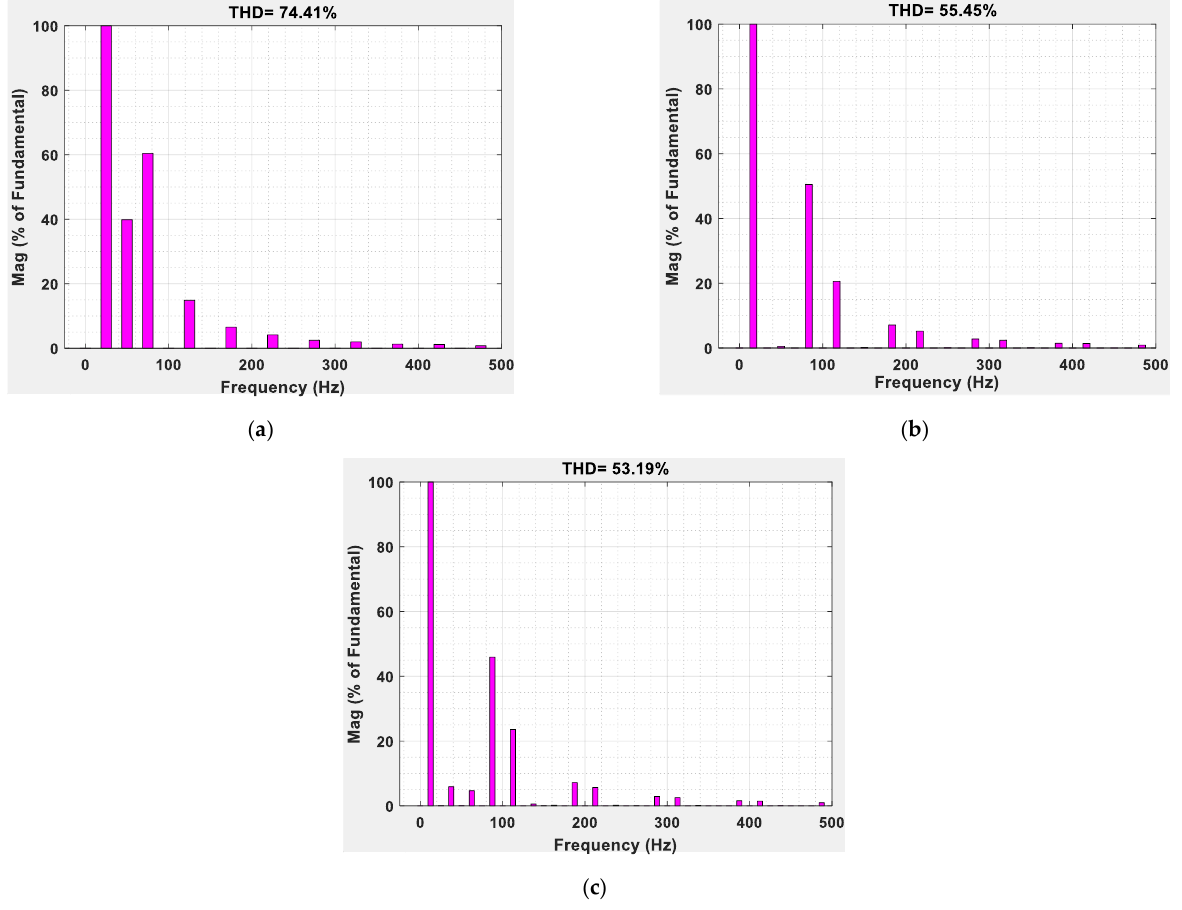
Figure 9. FFT spectrum of the output voltage with output voltage regulation capabilities for output frequency requirement: ( a ) one-half; ( b ) one-third; and ( c ) one-fourth.